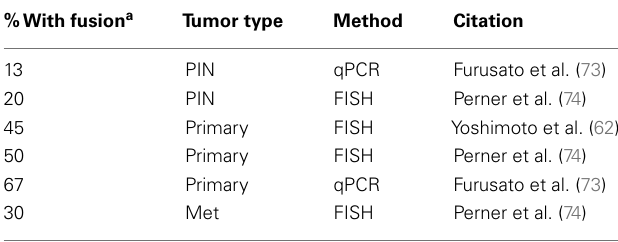
Table 2 | Pten loss in PCa . Table 3 |TMPRSS2/Erg fusions in PCa